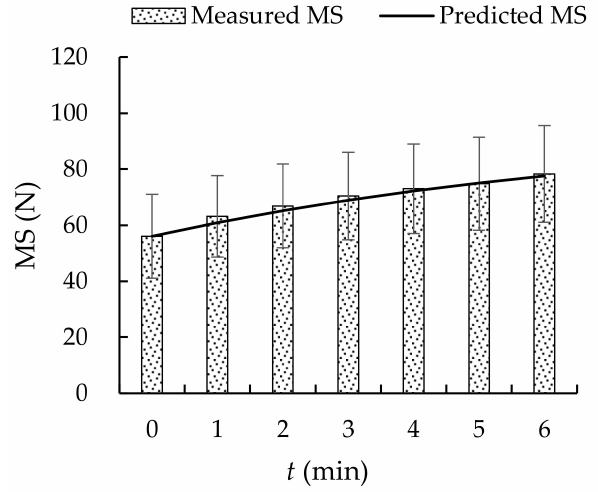
Figure 7. Measured and predicted MS showing MS